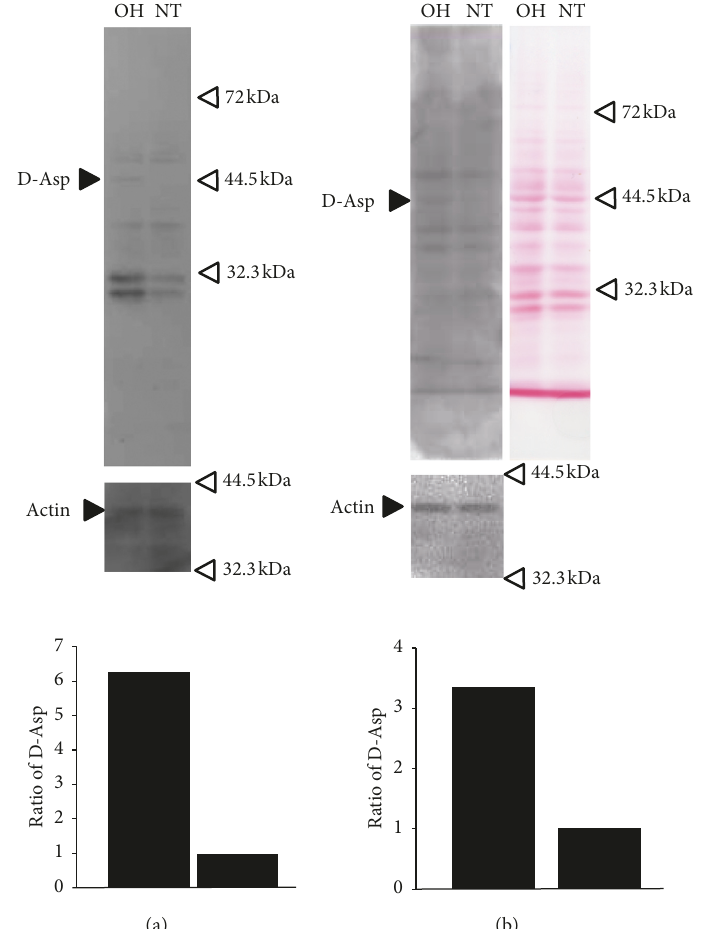
Figure 1: The expression of proteins containing D-aspartic acid in the retinas of rats with ocular hypertension and normotension. (a) Total lysates of retinas of rats with ocular hypertension (OH) and with normotension (NT) were applied to 10% acrylamide gel (SDS-PAGE) and blotted with anti-D-aspartic acid antibody. Blotting with anti-actin antibody was performed to standardize the total volume of applied proteins. The expression volumes of proteins containing D-aspartic acid were corrected with each actin expression, and the ratios at OH and NTare shown in the lowest panel. The black arrow, labelled D-Asp, shows a band with stronger expression in OH than NT. (b) Total lysates of retinas of OH and NT were blotted with anti-D-aspartic acid antibody (a) and stained with Ponceau solution